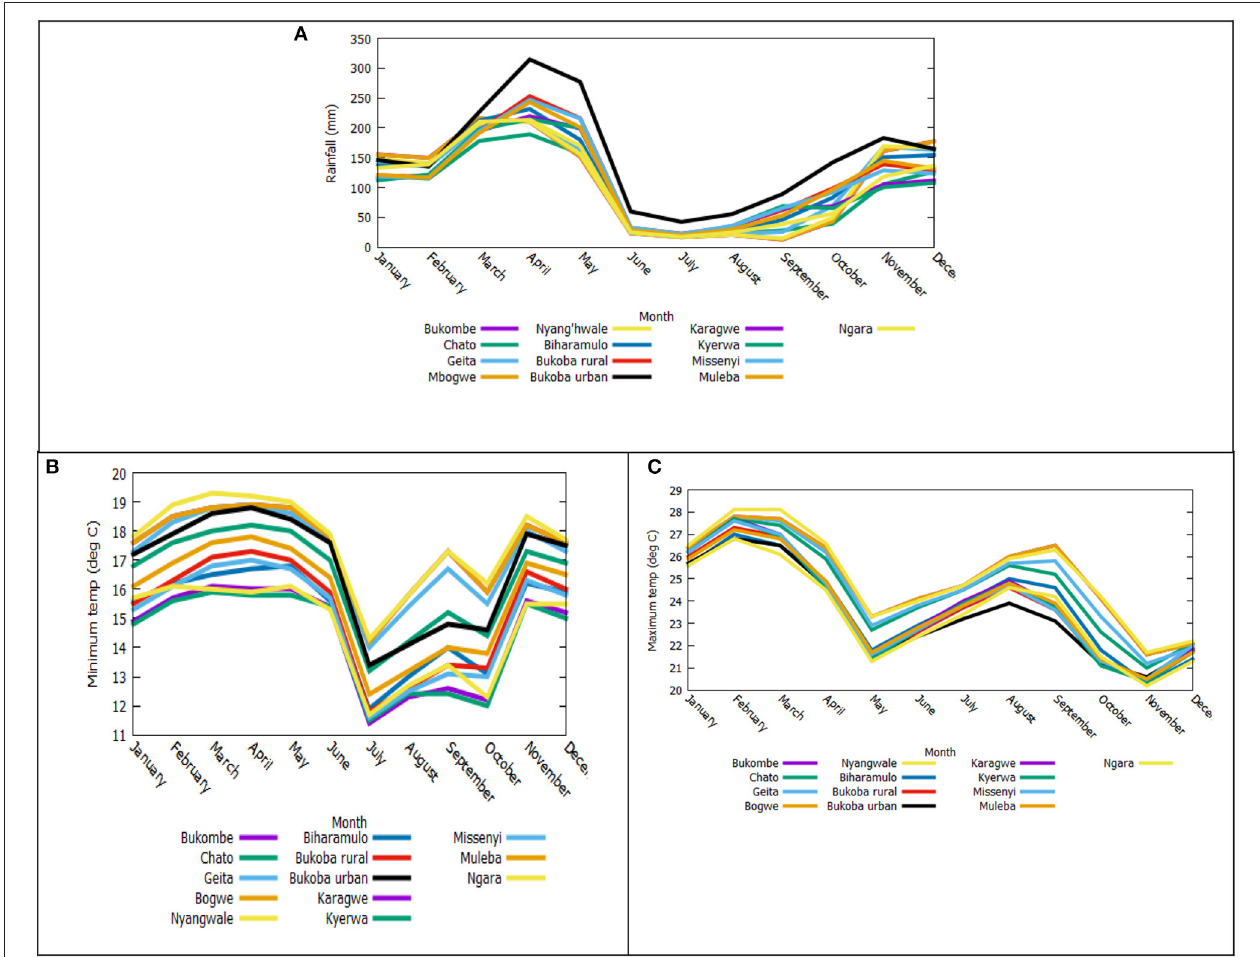
FIGURE 3 | The annual cycle of rainfall and minimum and maximum temperatures in the Kagera and Geita regions during the historical climate (1971–2000). (A) Rainfall. (B) Minimum temperature. (C) Maximum temperature.